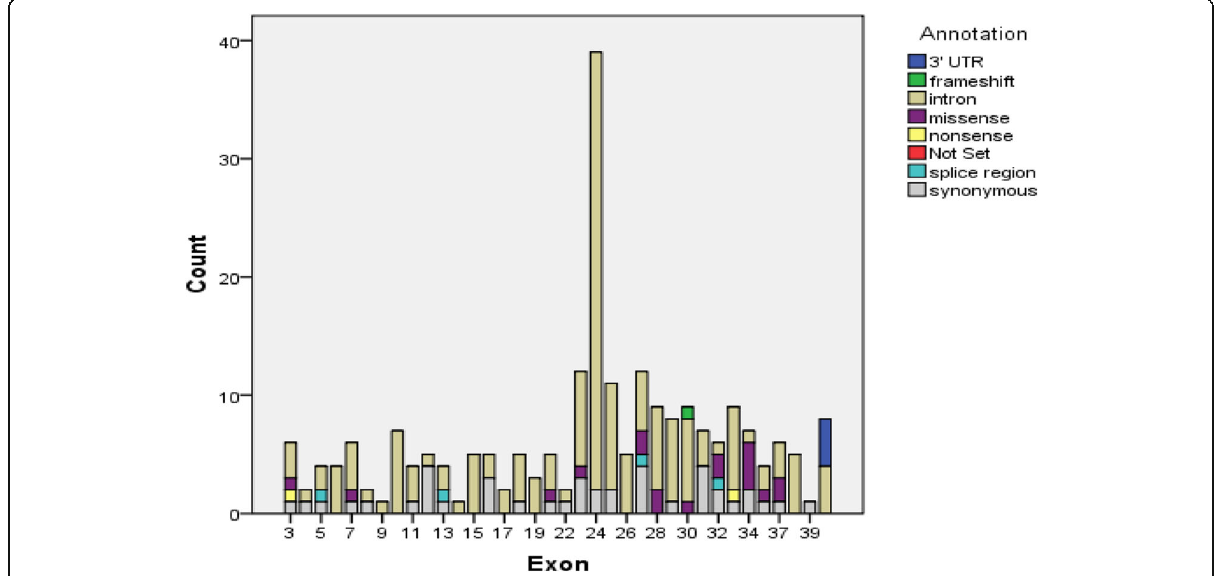
Fig. 2 Distribution of variants according to their exonic-intronic